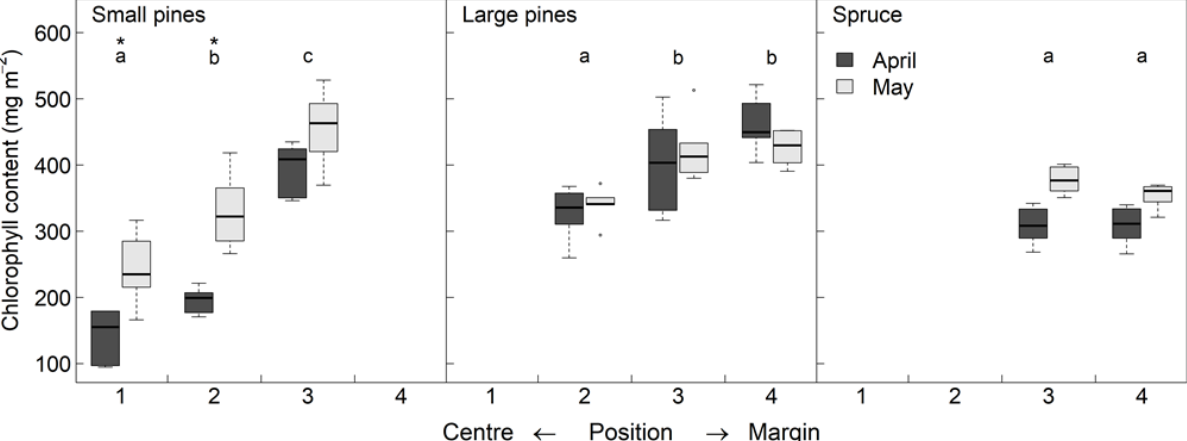
Figure 3. Chlorophyll content in Pinus rotundata (Small and Large pines) and Picea abies (Spruce) needles in April and May 2014. Asterisks indicate significant differences between the April and May measurement periods. Different letters indicate significant differences between the positions along the two transects.